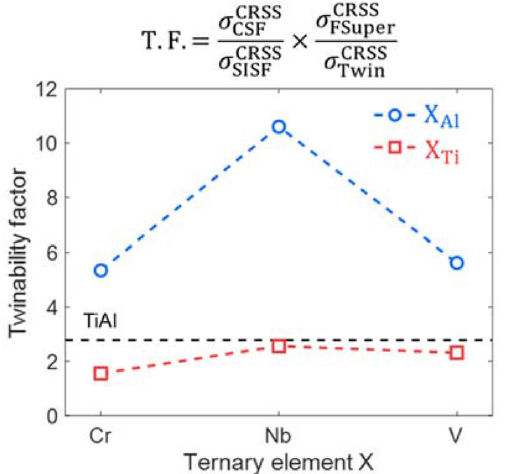
Figure 8. Calculated twinnability factor of each ternary alloy considering the substitution of a Ti (X Ti ) or Al (X Al ) site by an alloying element X (Cr, Nb, or